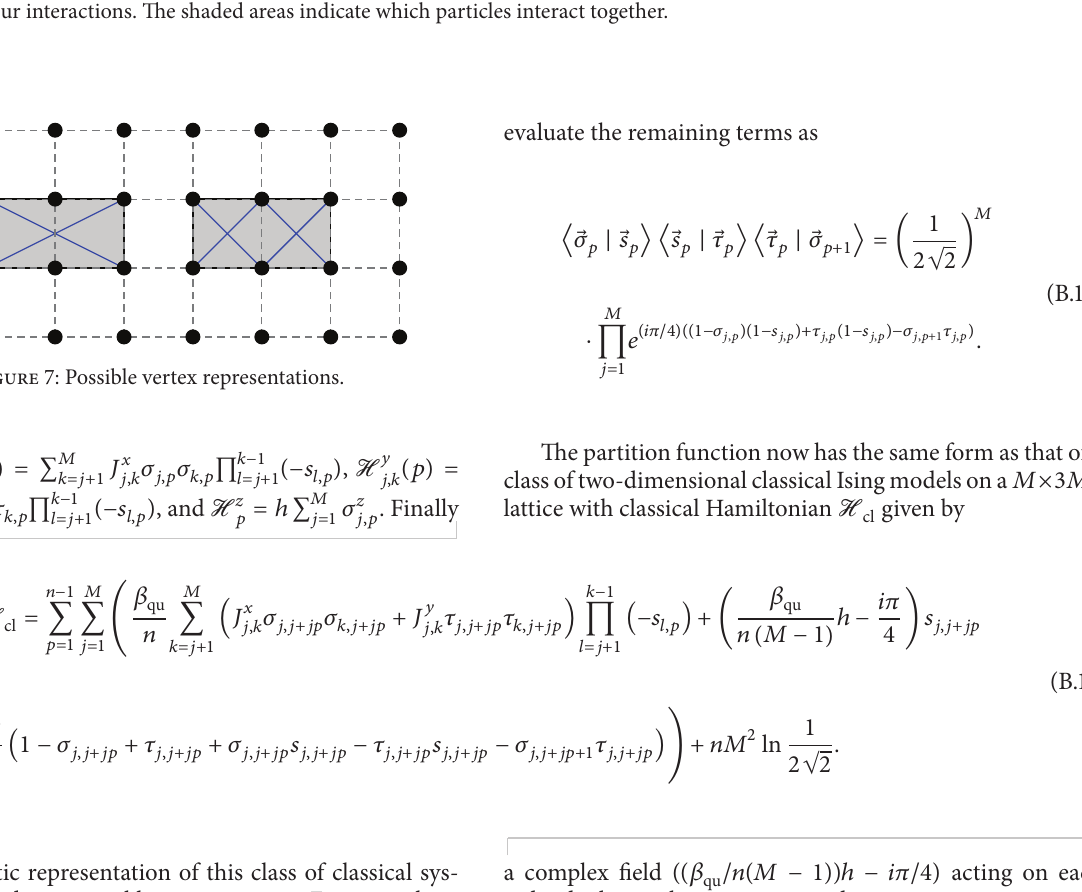
Figure 6: Lattice representation of a class of classical systems equivalent to the class of quantum systems (1) restricted to nearest and next nearest neighbour interactions. The shaded areas indicate which particles interact together.